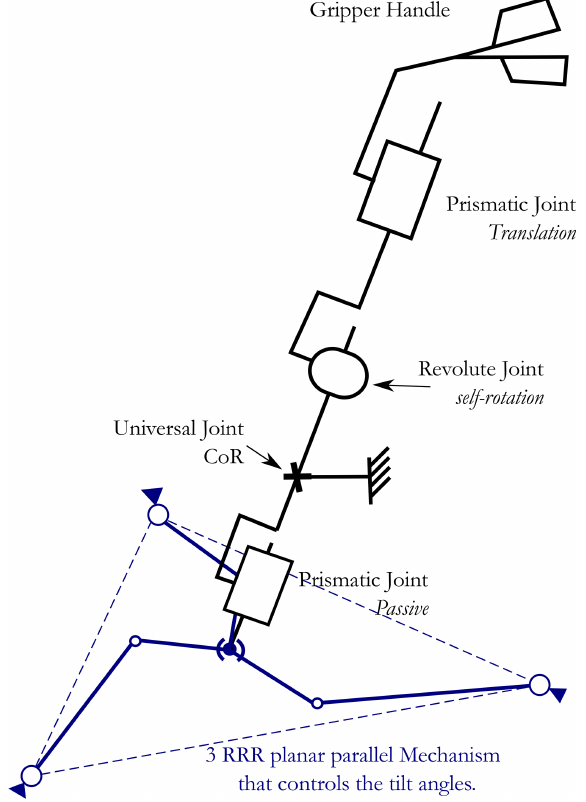
Figure 4. New hybrid-haptic device